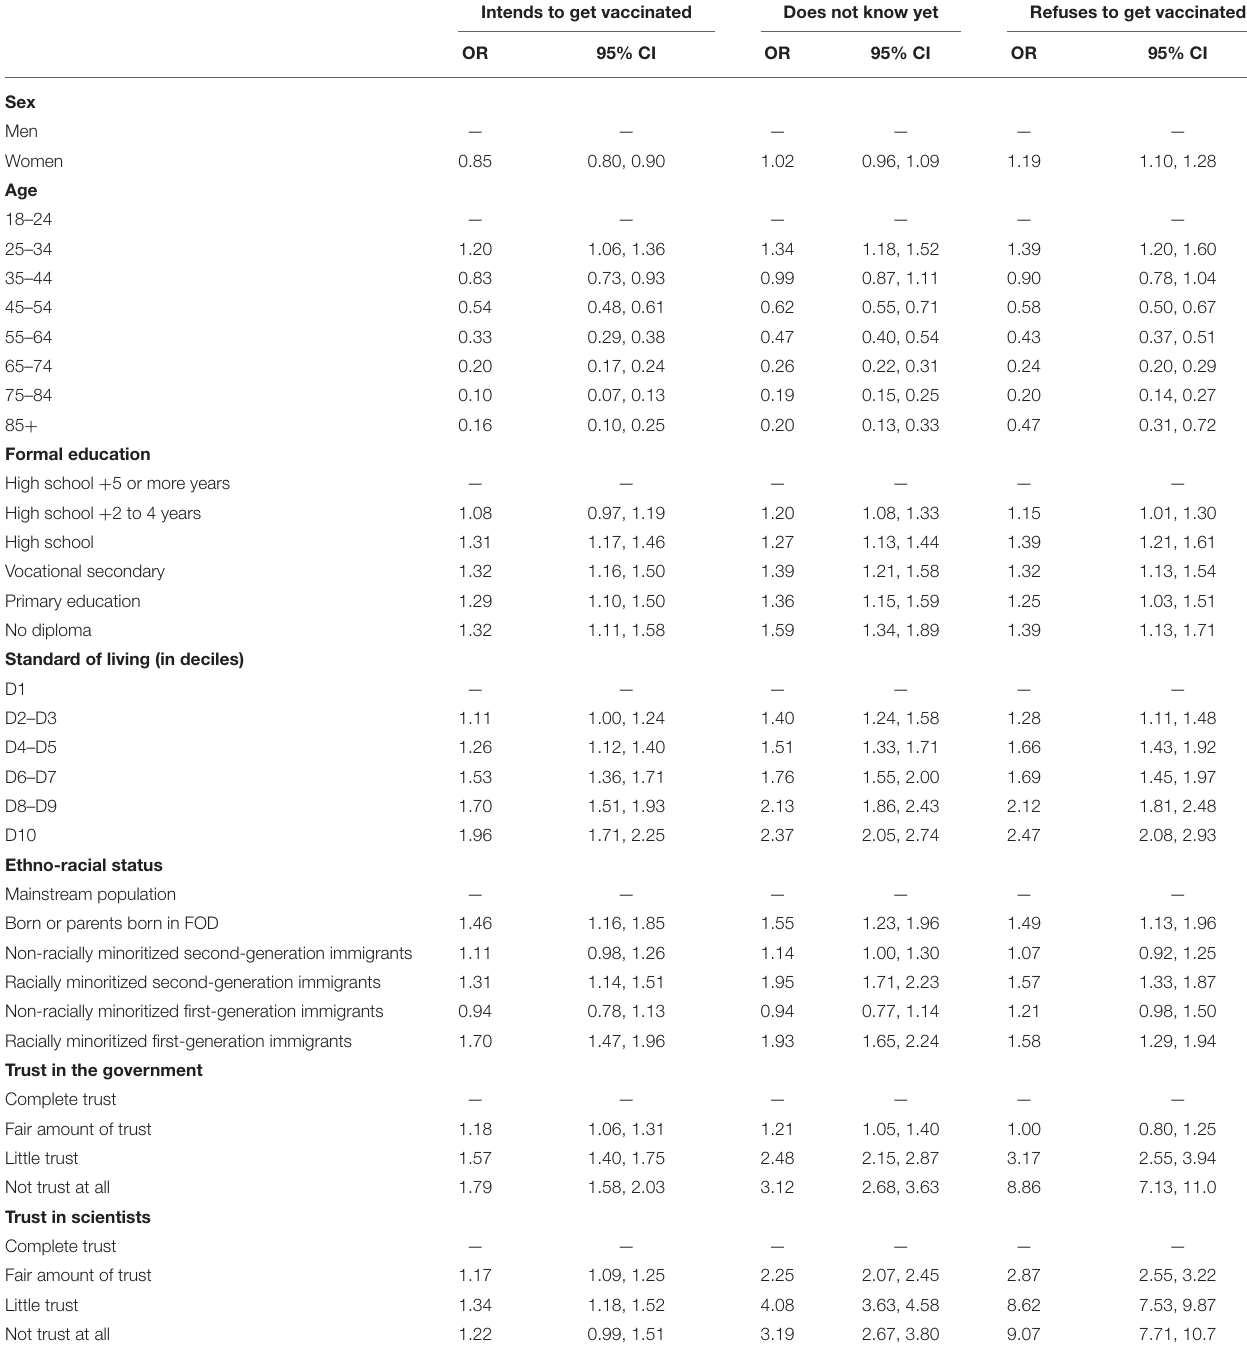
TABLE 2 | Factors associated with vaccination status (multinomial regression, reference = being vaccinated). Intends to get vaccinated Does not know yet Refuses to get vaccinated OR 95% CI OR 95% CI OR 95%